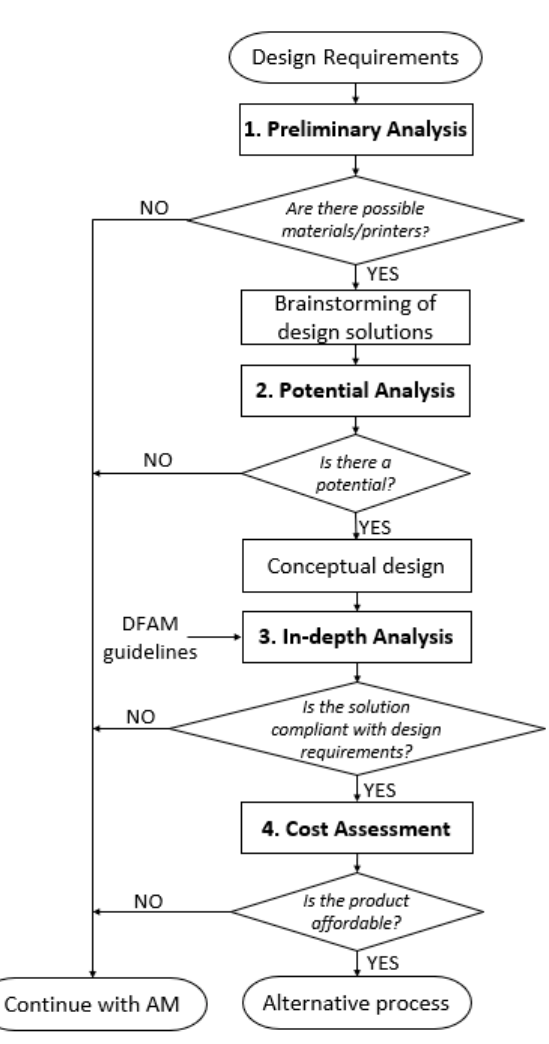
Figure 1. General framework of the design approach for AM parts.